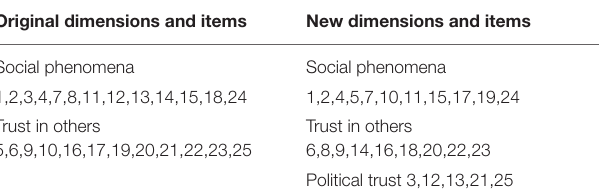
Original dimensions and